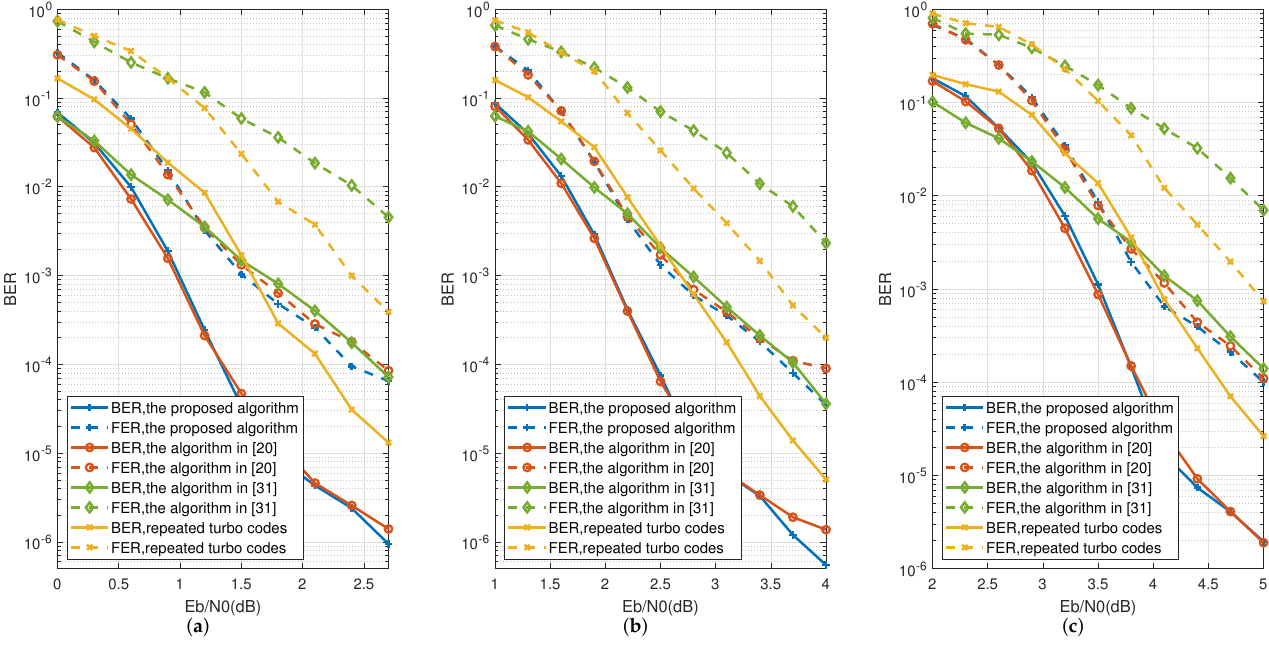
Figure 9. Error performance of turbo-Hadamard codes with r = 4 with no jamming ( a ), 20% ( b ), 40% ( c ) frequency bins to be